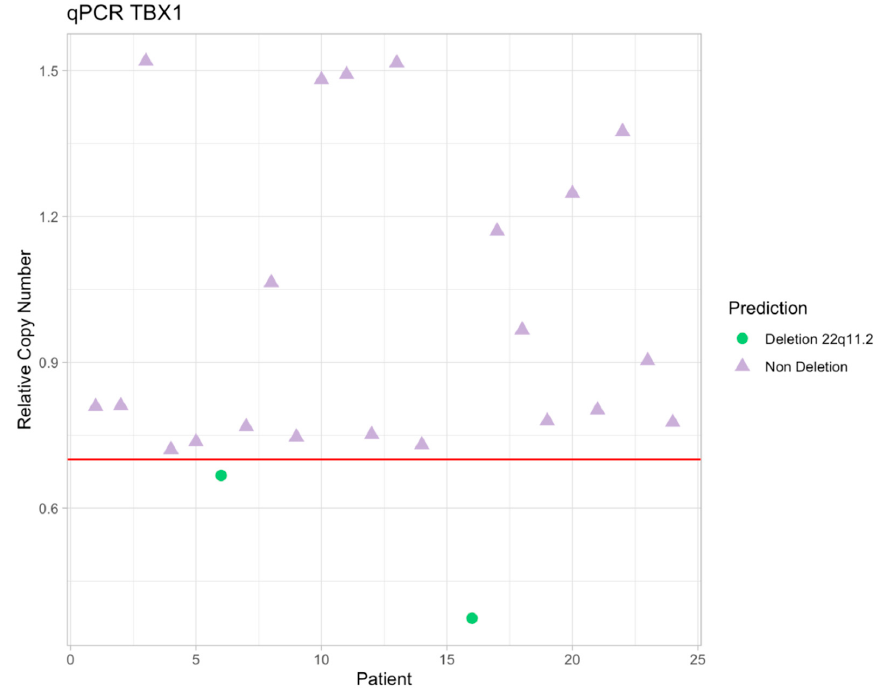
Figure 1. Distribution of the relative copy number of TBX1 detected by qPCR. Patients with a 2 −ΔΔ CT : < 0.70 (red line) were considered to possibly have 22q11.2 deletion syndrome (round points) and MLPA analysis candidates.